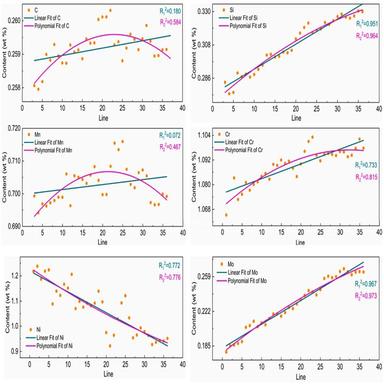
Inter-row general trend of C, Si, Mn, Cr, Ni, Mo elements of A11 sample.